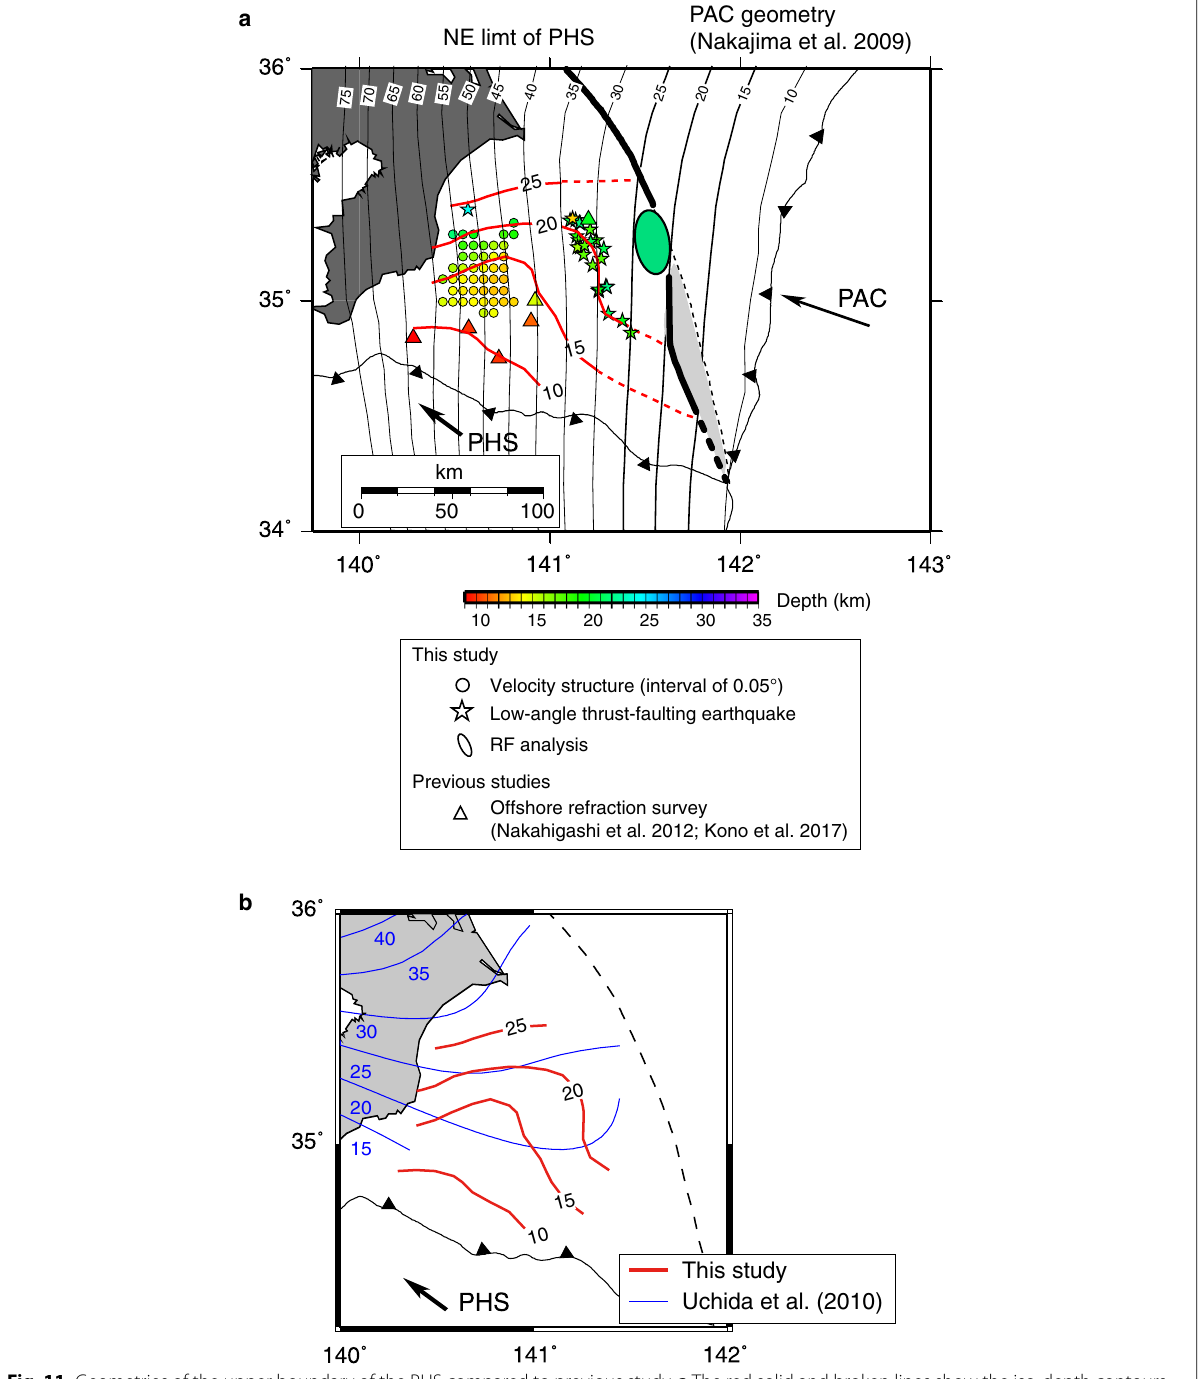
Fig. 11 Geometries of the upper boundary of the PHS compared to previous study. a The red solid and broken lines show the iso-depth contours of the upper boundary of the PHS based on the tomographic images (circles), the locations of low-angle thrust-faulting earthquakes (stars), and previous refraction studies (triangles). The depths from previous refraction studies are 9 km, 10 km, and 11 km for the upper boundaries of the PHS along a survey line in Kono et al. (2017) and 10 km, 15 km, and 20 km along a survey line in Nakahigashi et al. (2012). The colors of the symbols correspond to the depth. The green region shows the area where phase “6” (the converted wave at the plate boundary between the NA and PHS) was observed in the RF analysis. The north–south trending curves indicate the iso-depth contours of the upper boundary of the PAC. The black bold and broken lines define the edge of the PHS, and the gray-shaded zone presents the gap between this study and that of Uchida et al. (2009). b The red and blue lines show the depths of the upper boundaries of the PHS derived in this study and those derived by Uchida et al. (2010),